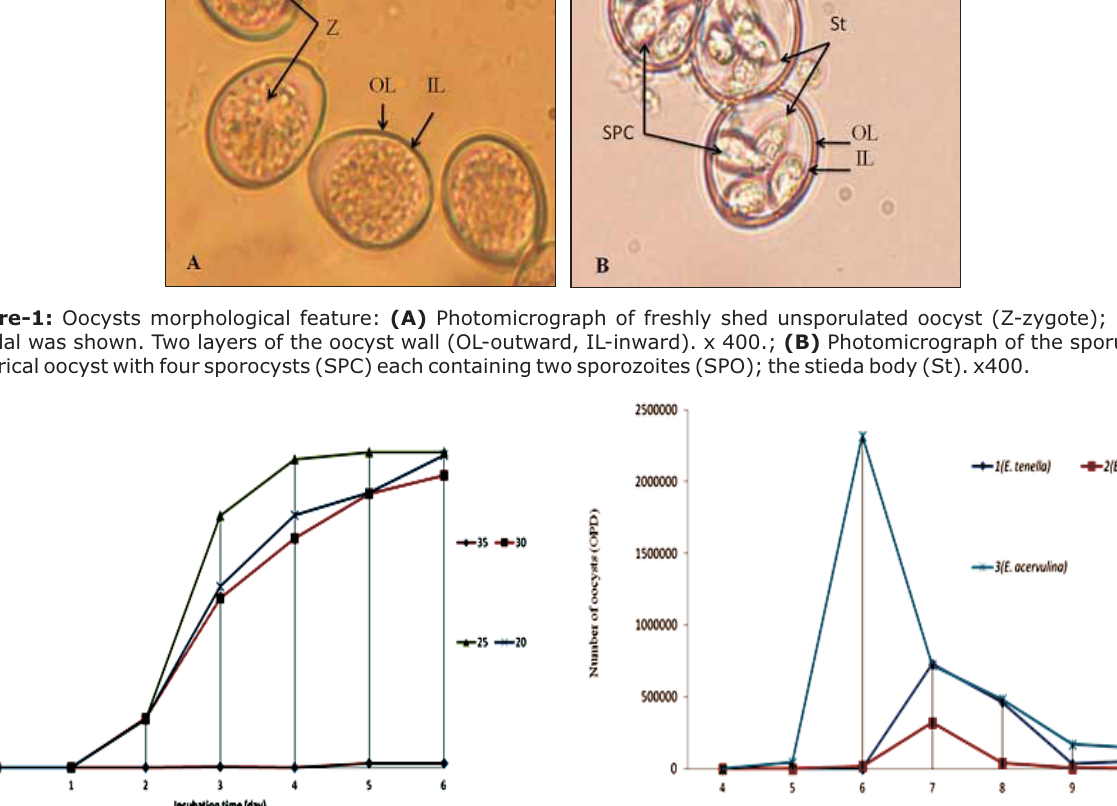
Eimeria Figure-3: Fecal oocysts shedding in chickens infected with Figure-2: Mean sporulation rate of in water bath Eimeria tenella, E. acervulina E. and . Each data with different temperature. point shows the average oocysts of four counts.